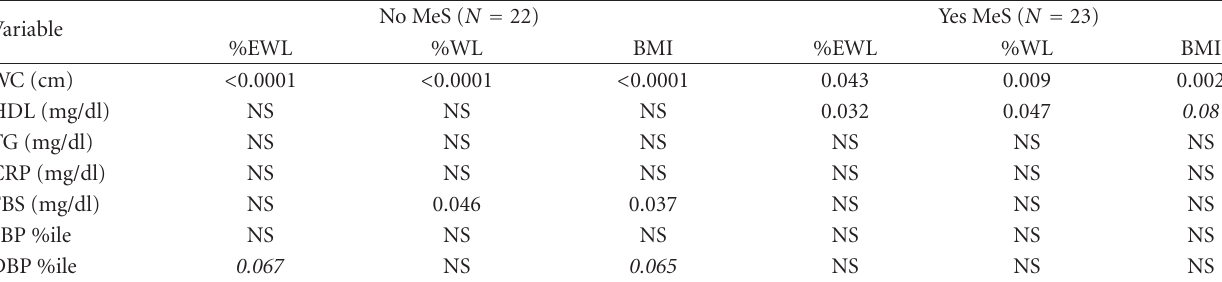
Table 5: P -values for correlations among weight change measures and components of MeS at 12m post-LAGB by MeS status at baseline. No MeS ( N = Variable